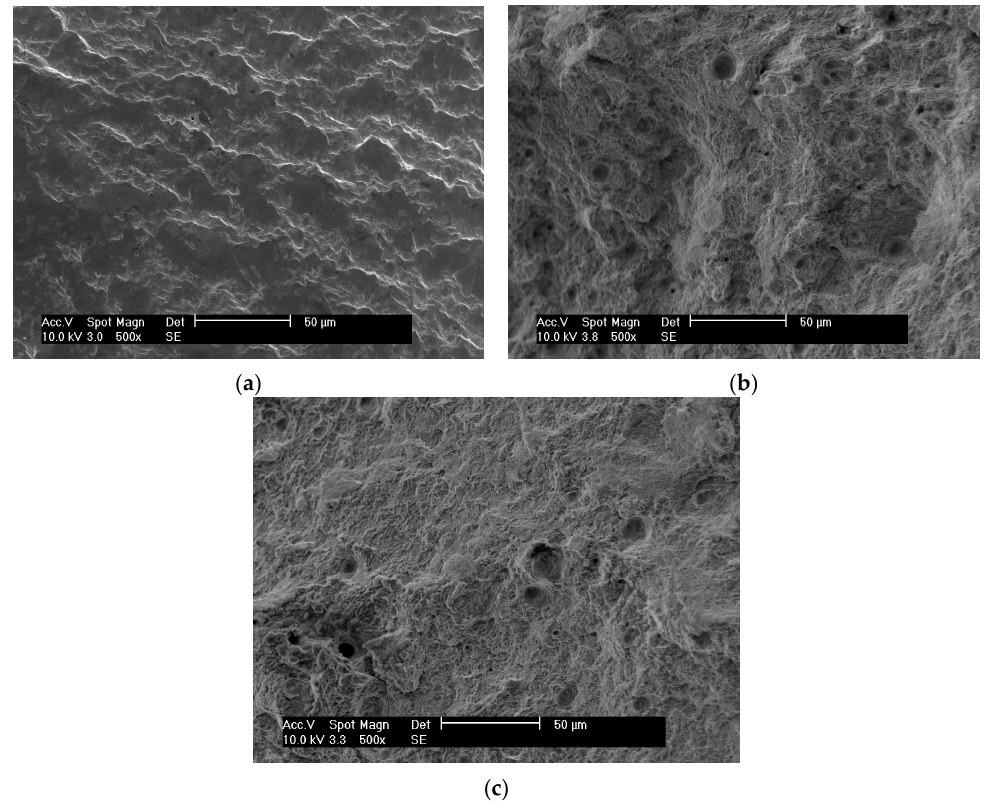
Figure 13. SEM micrographs of fracture surfaces near the crack initiation sites for different total strain amplitudes: ( a ) Δε /2 = 0.4%; ( b ) Δε /2 = 1.0%; ( c ) Δε /2 = 2.0% [5]. Reprinted from Theoretical and Applied Fracture Mechanics , Vol. 58, Branco, R.; Costa, J.D.; Antunes, F.V. Low-cycle fatigue behavior of 34CrNiMo6 high strength steel, 28–34, Copyright (2012), with permission from Elsevier.